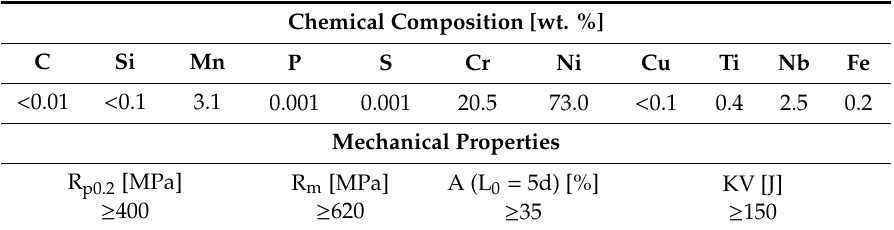
Table 3. Chemical composition and mechanical properties at the 20 ◦ C of S Ni 6082 filler metal according to the inspection